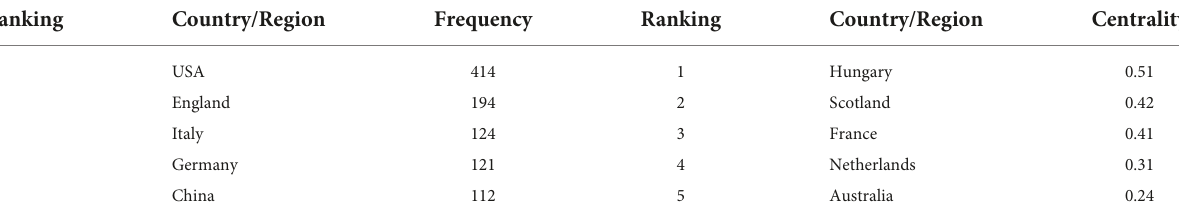
TABLE 1 The top 10 countries/regions related to Tourette Syndrome (TS) in children research from 2011 to 2021. Ranking Country/Region Frequency Ranking Country/Region